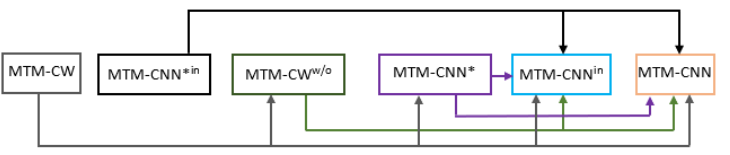
Figure 10. Graphical representation of the Friedman test for MTM-CW vs. MTM-CNN. The arrows show models that are statistically significant with each